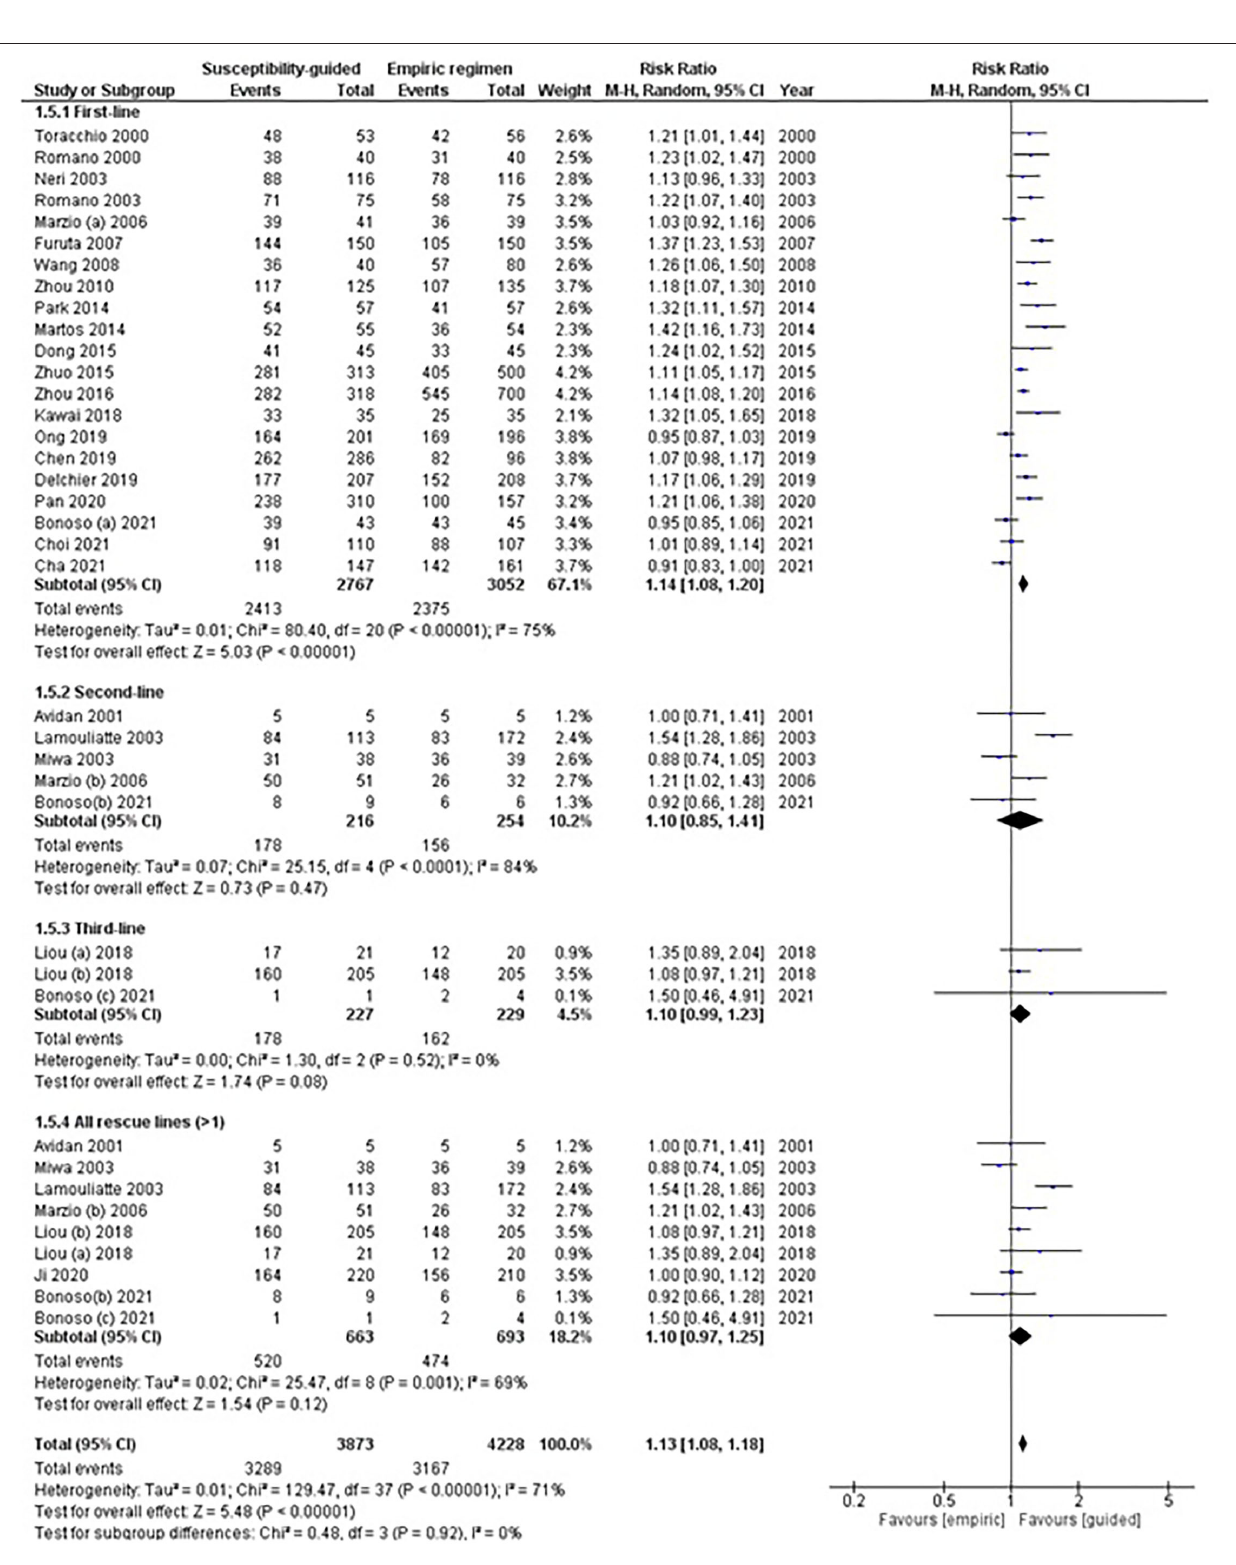
Frontiers in Microbiology |